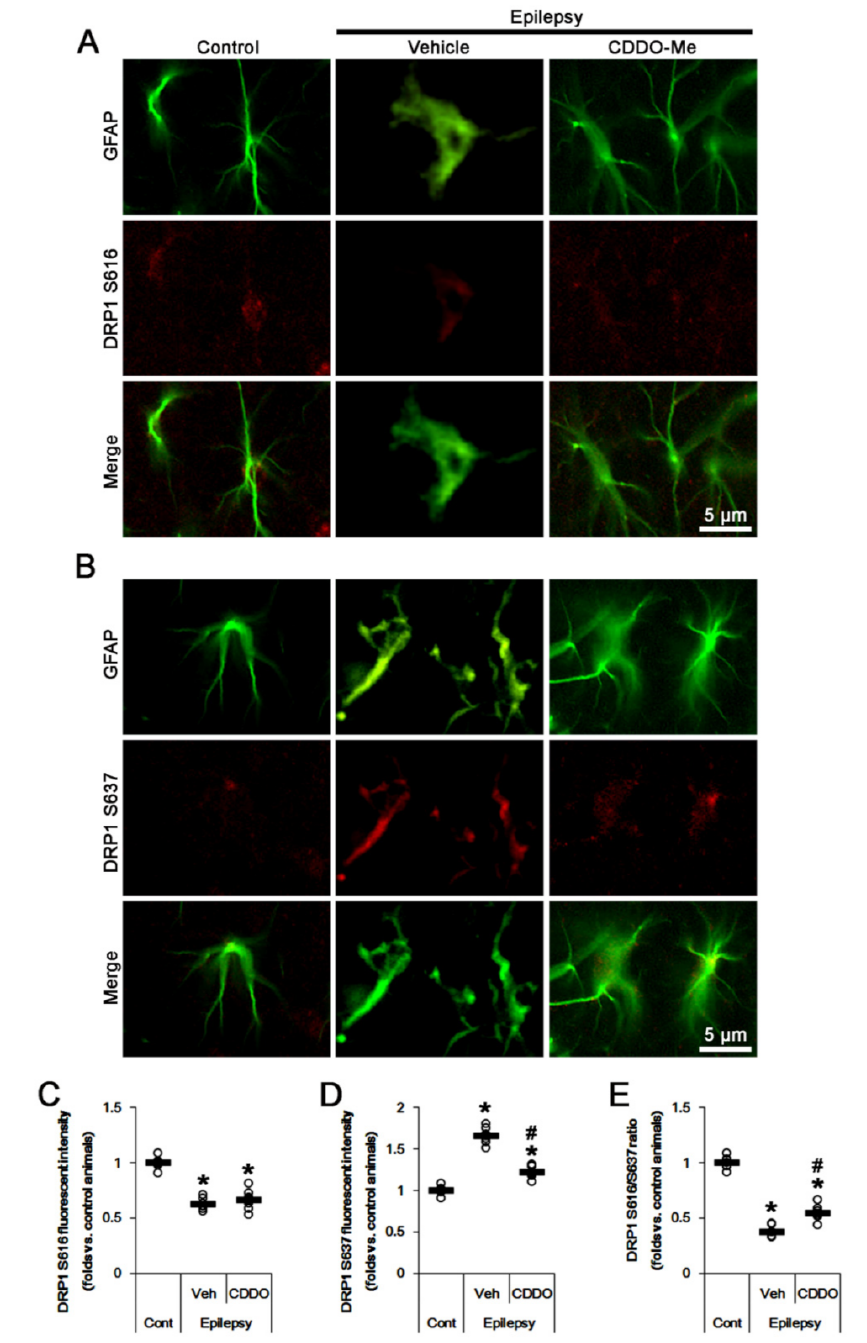
Figure 3. Effects of CDDO-Me on DRP1 S616- and S637 phosphorylations in CA1 astrocytes of control and epileptic rats. As compared to control animals (Cont), DRP1 S616 phosphorylation is reduced in CA1 astrocytes in epileptic rats, while DRP1 S637 phosphorylation is increased. CDDO-Me reduces the increased DRP1 S637 phosphorylation in CA1 astrocytes without affecting DRP1 S616 phosphorylation, as compared to vehicle (Veh). ( A , B ) Representative photos demonstrating astroglial DRP1 S616- ( A ) and S637 phosphorylation ( B ) in CA1 astrocytes. ( C – E ) Quantifications of DRP1 S616- ( C ), S637 phosphorylation ( D ) and DRP1 S616/S637 phosphorylation ratio ( E ) in CA1 astrocytes. Open circles indicate each value. Horizontal bars indicate the mean value. Error bars indicate SEM (*, # p < 0.05 vs. control and vehicle-treated epileptic rats, respectively; n = 7,